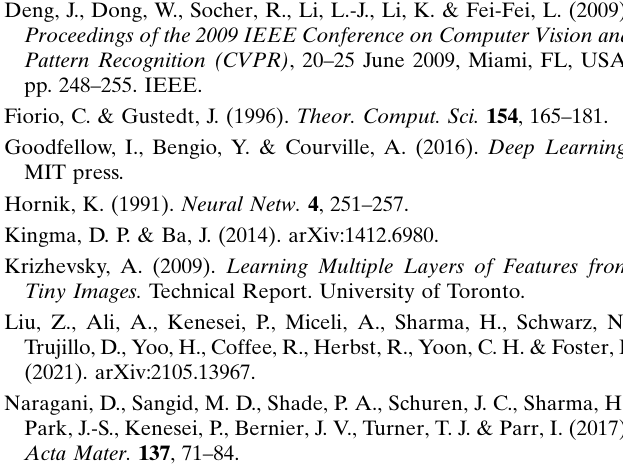
Figure 9 Distribution of difference between peak positions located by BraggNN [right: with ( m ; n 2 f(cid:7) 1 ; 0 ; 1 g ) or left: without data augmentation] and conventional pseudo-Voigt fitting. P n th denotes the n th percentile.